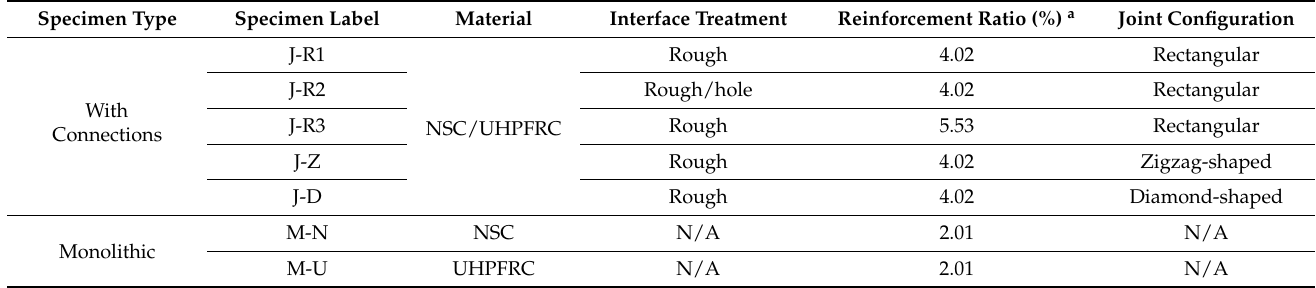
Table 3. Details of test specimens.